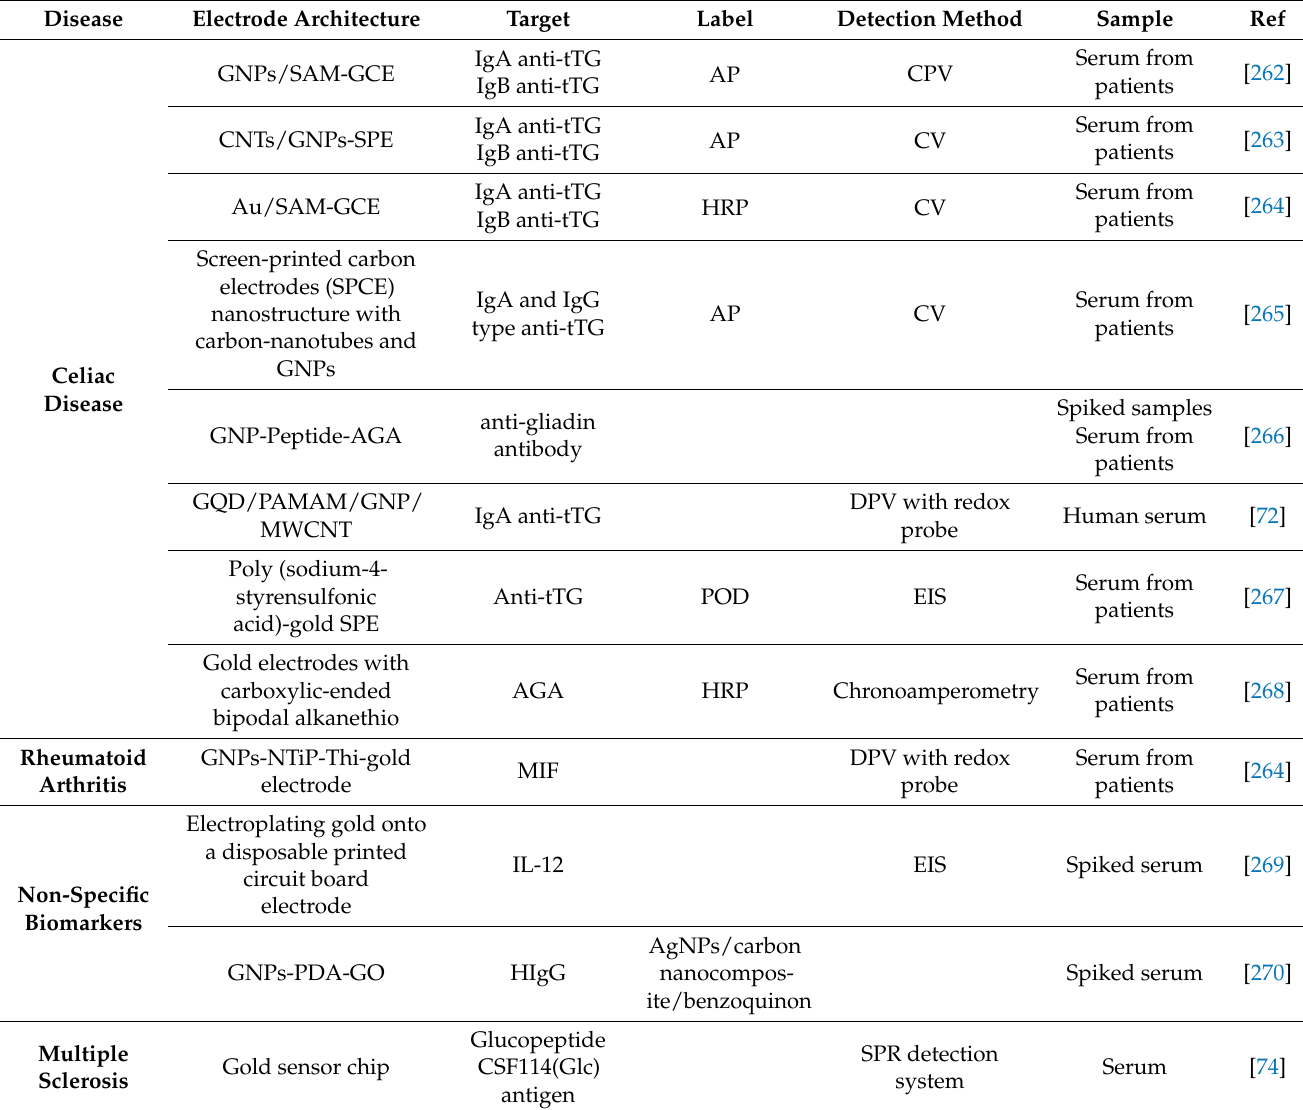
Table 2. Gold nanoparticle-based applications for diagnosis and monitoring of autoimmune diseases.